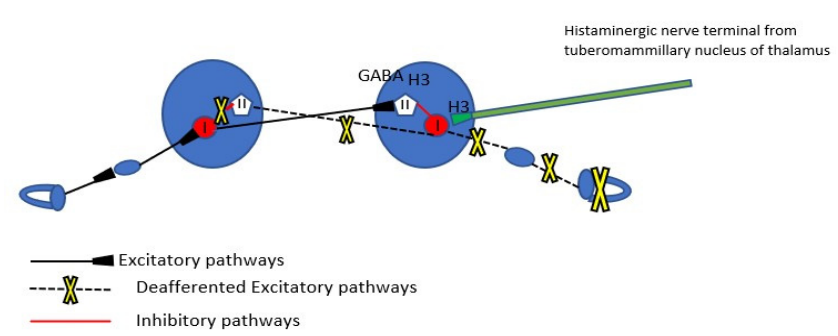
Figure 2. The commissural pathway modulations immediately after unilateral vestibular deafferenta- tion. Type I neurons in the MVN of the ipsilesional side are silenced because of interruption of the peripheral vestibular input, but also by the inhibitory activity of Type II neurons of the same nucleus which are not only spared but potentiated by the exacerbated activity of contralateral Type I neurons which in turn are disinhibited by the disfacilitation of Type II inhibitory neurons of the healthy Medial Vestibular Nucleus (MVN). GABAergic receptors and H3 heteroreceptors (presynaptic) from commissural fibers to Type II neurons are also noted. The precynaptic H3 receptors on the histaminergic nerve terminals from the tuberomamilary nucleus of thalamus are noted (see below).